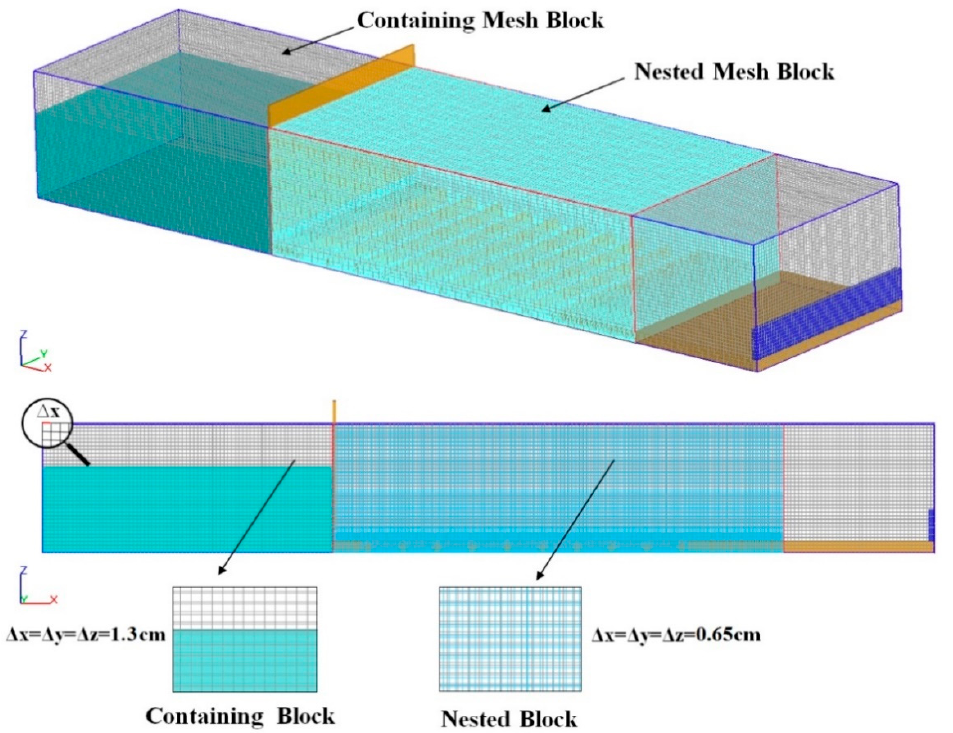
Figure 4. Sketch of mesh setup. Table 4. Characteristics of the computational grids.